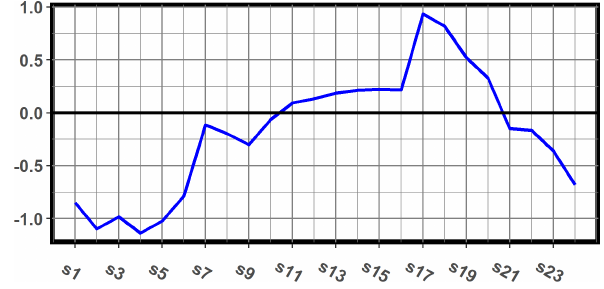
Figure 10: Seasonality curve for the Holt-Winters model